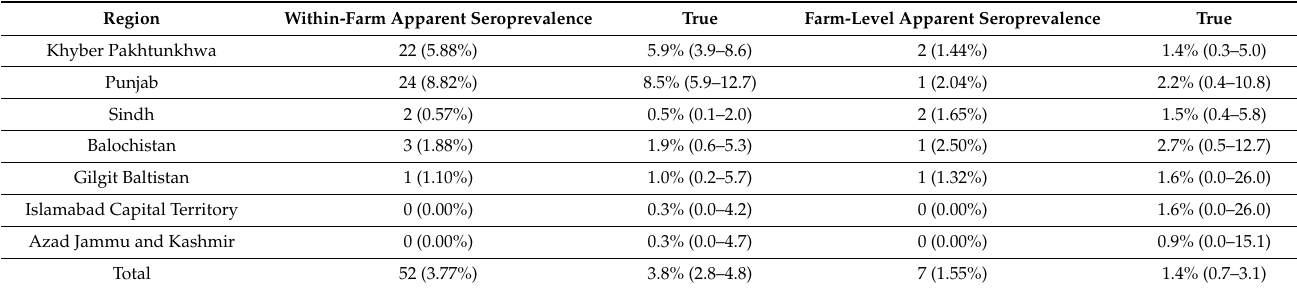
Table 2. Within-farm and farm-level seroprevalence estimates of BLV infection per region, summarized by the median and 95% credibility intervals.